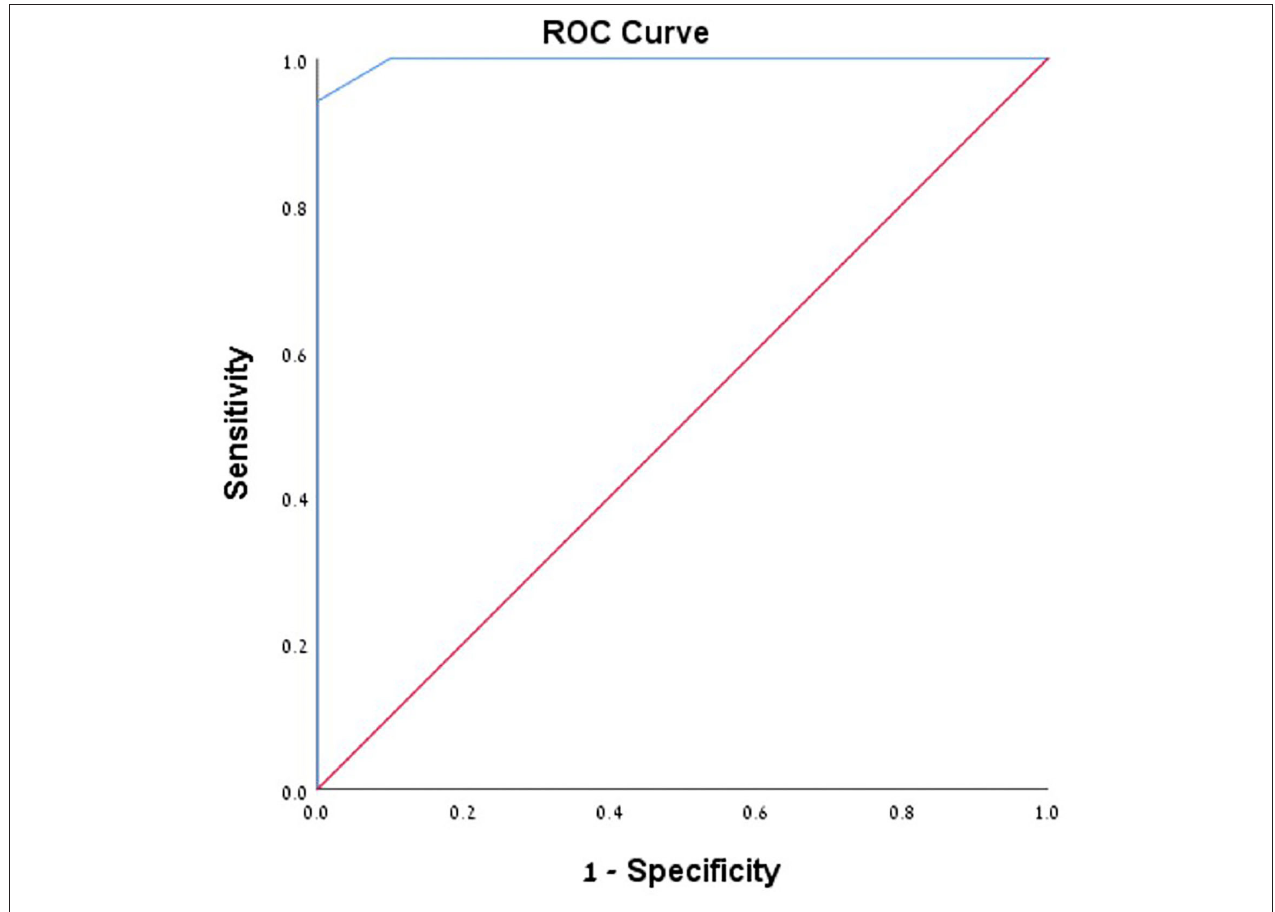
FIGURE 3 | ROC curve analysis of pressure wire method.